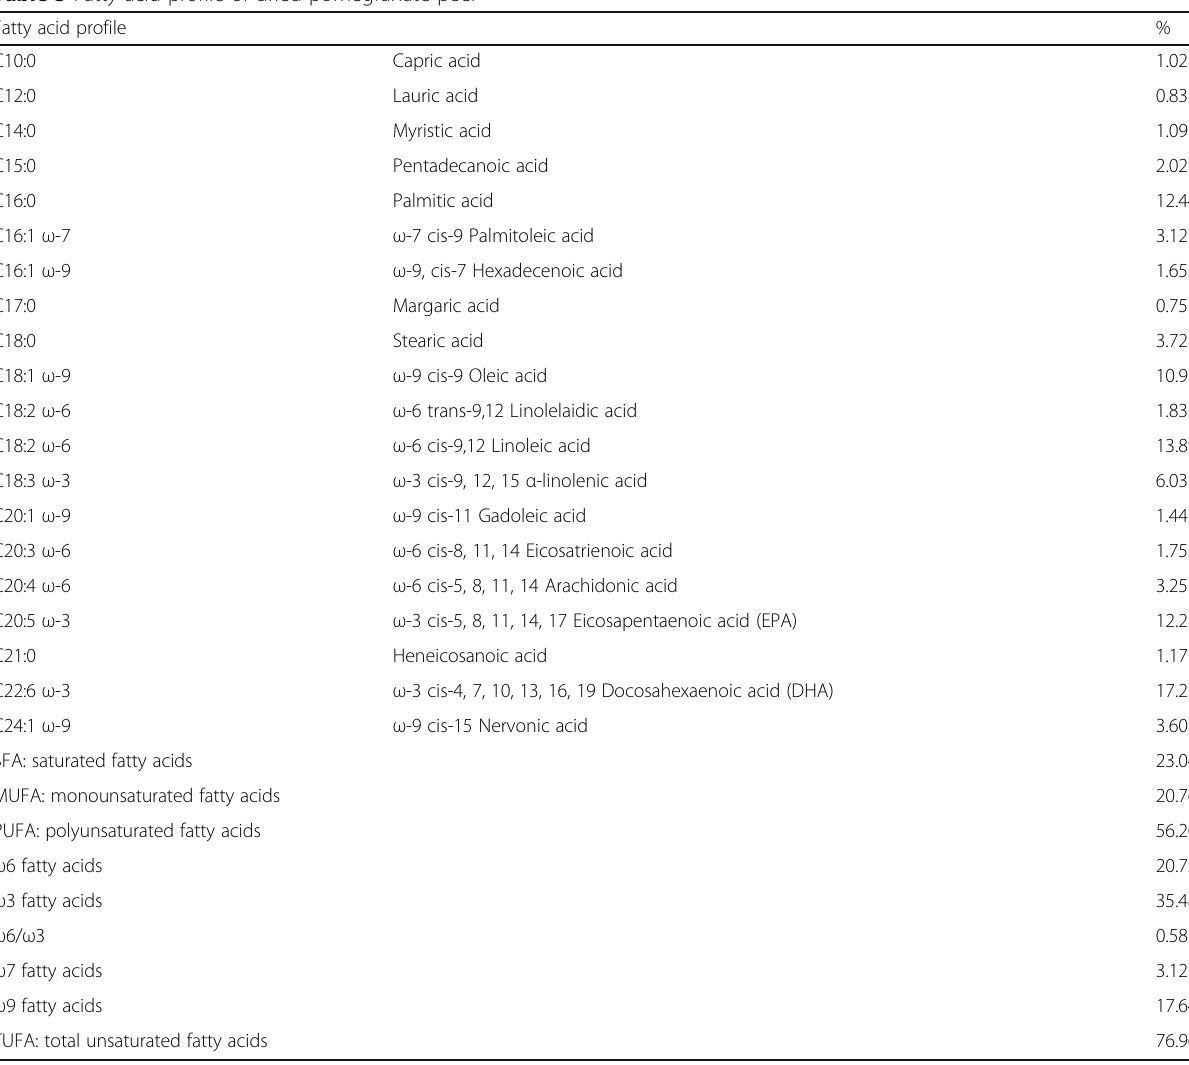
Table 5 Fatty acid profile of dried pomegranate peel Fatty acid